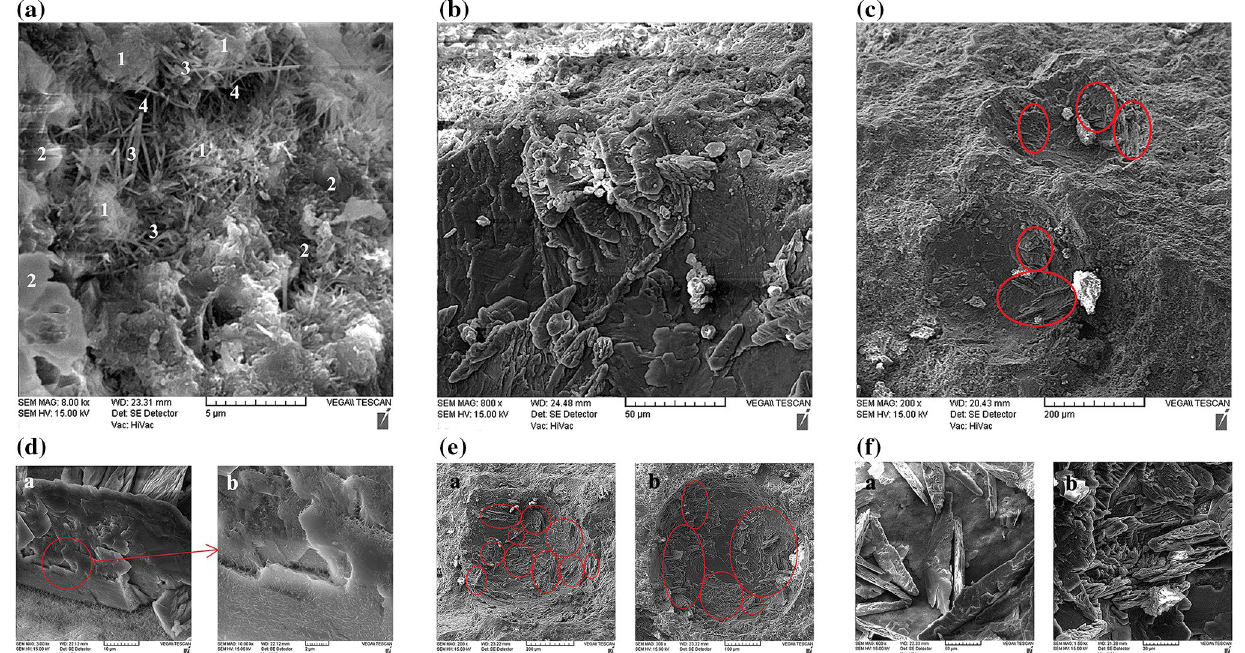
Fig. 14 SEM micrographs of SCC concrete produced with and without clay nanoparticles [33]: a : control specimen. 1 = C-S–H, 2 = Ca(OH) , 3 = ettringite, 4 = pore; b : arrangement of nano-clays 2 in the SCC sample with 0.5% of clay nanoparticles; c :